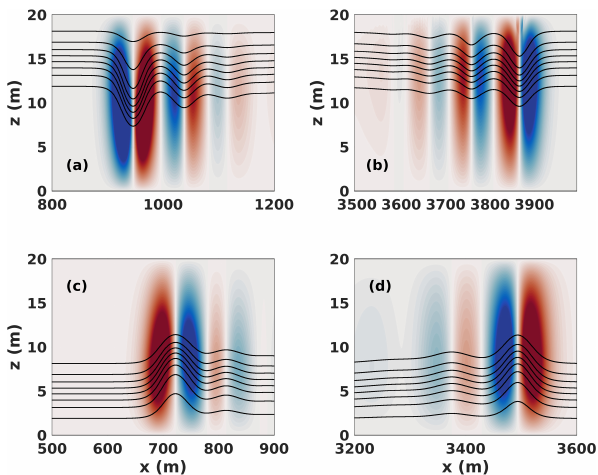
Figure 4. Sample wave trains at a late time ( t = 21600s) for Case NO DJL 1. (a) Scaled density and (b) vertical component of veloc-